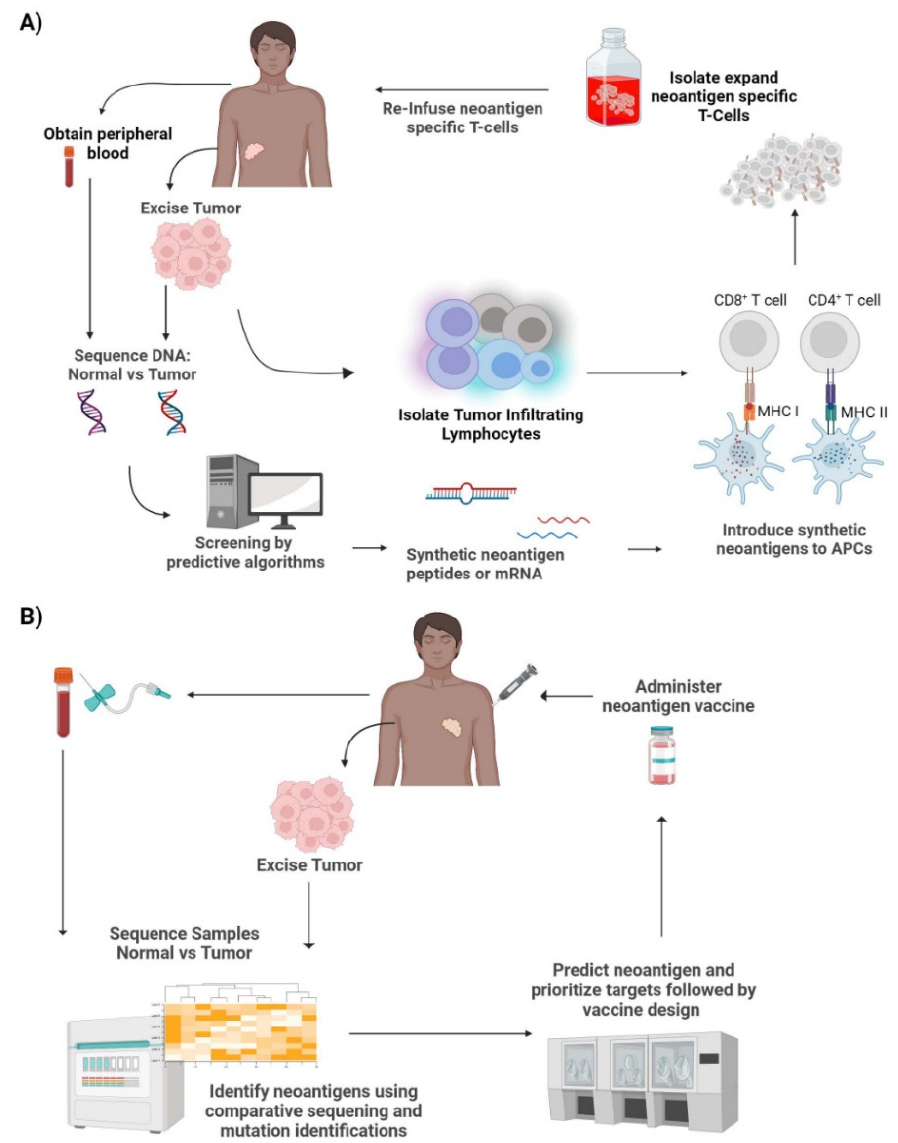
Figure 3. Neoantigen therapies. ( A ) Neoantigen specific T-cell therapy —Tumor cells biopsied from the patient can be used for exome/transcriptome sequencing and computational screening to create syn- thetic neoantigen DNA, mRNA, or peptides. These antigens are processed by APCs and presented to T cells leading to T cell activation. The activated T cells with TCRs specific to the neoantigens are then isolated and expanded. This is then reinfused back into the patient. ( B ) Neoantigen vaccines —Tumor cells excised from the patient undergo comparative sequencing and mutation identification with the patient’s normal cells. This is then used to predict neoantigens and prioritize targets. This is followed by vaccine design, production, and finally administered to the patient. Credits: Images were created using BioRender.